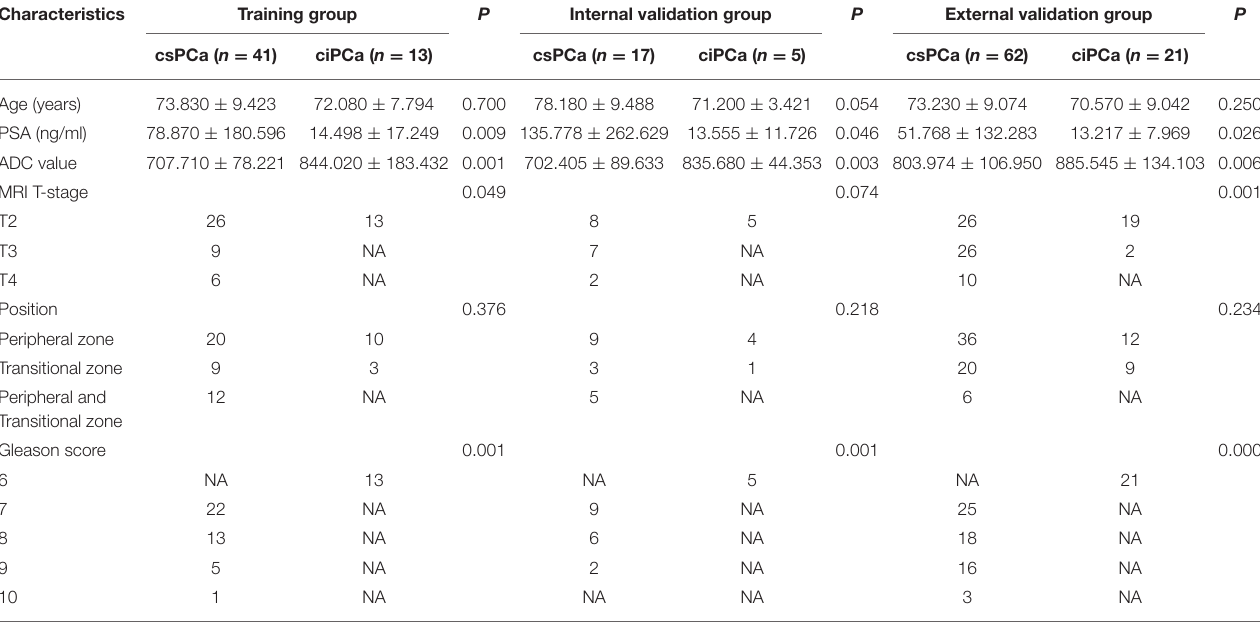
TABLE 1 | Characteristics of patients in the training and validation groups. Characteristics